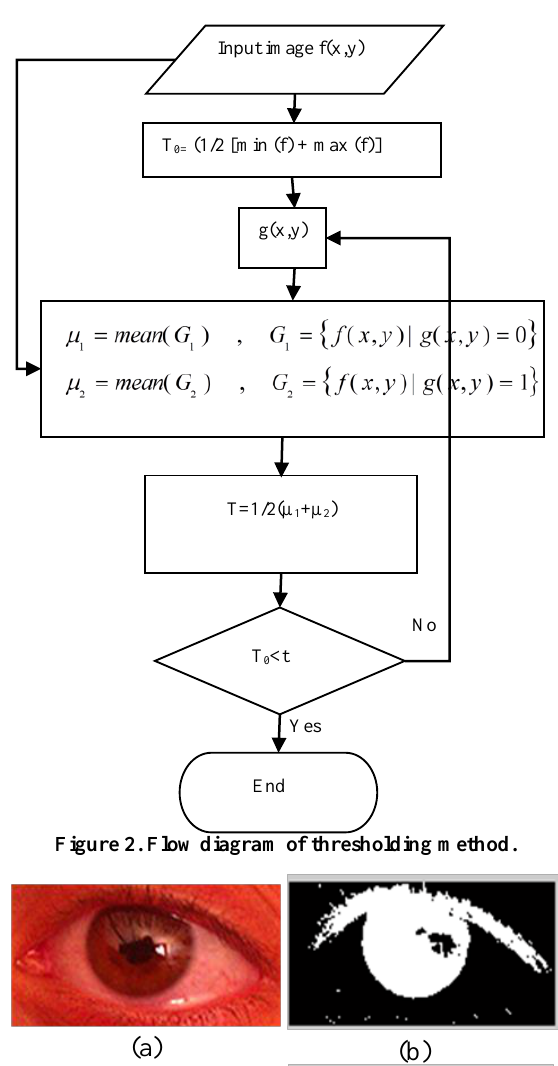
Figure 3. (a) eye image, (b) thresholding result (by process described in figure 2), (c) opening result, (d) result of Laplacian edge